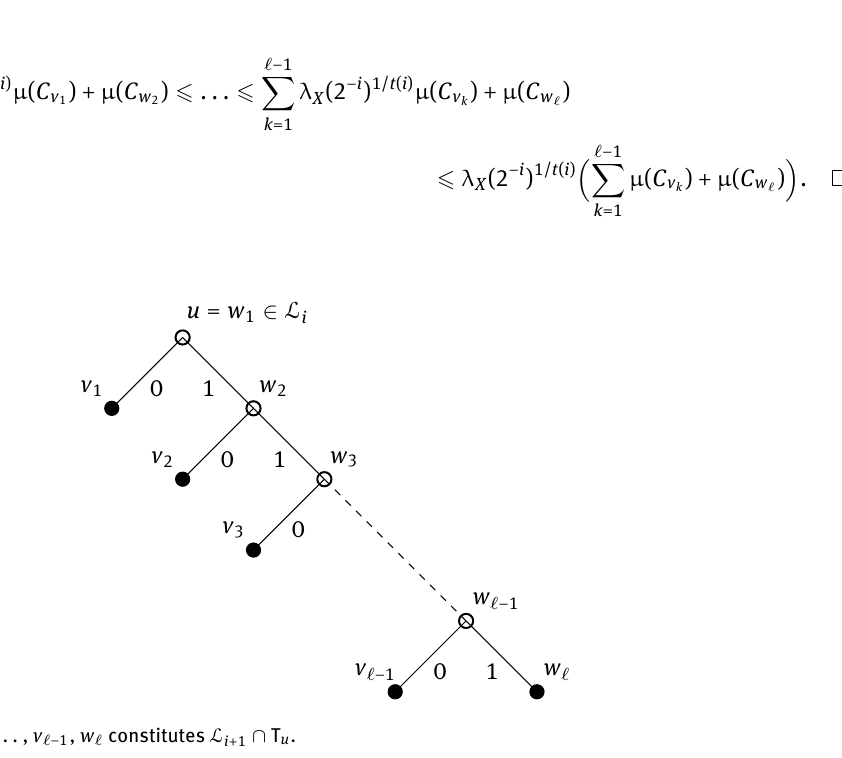
Figure 1: The vertices v 1 , . . . , v (cid:96) −1 , w (cid:96) constitutes L i +1 ∩ T u